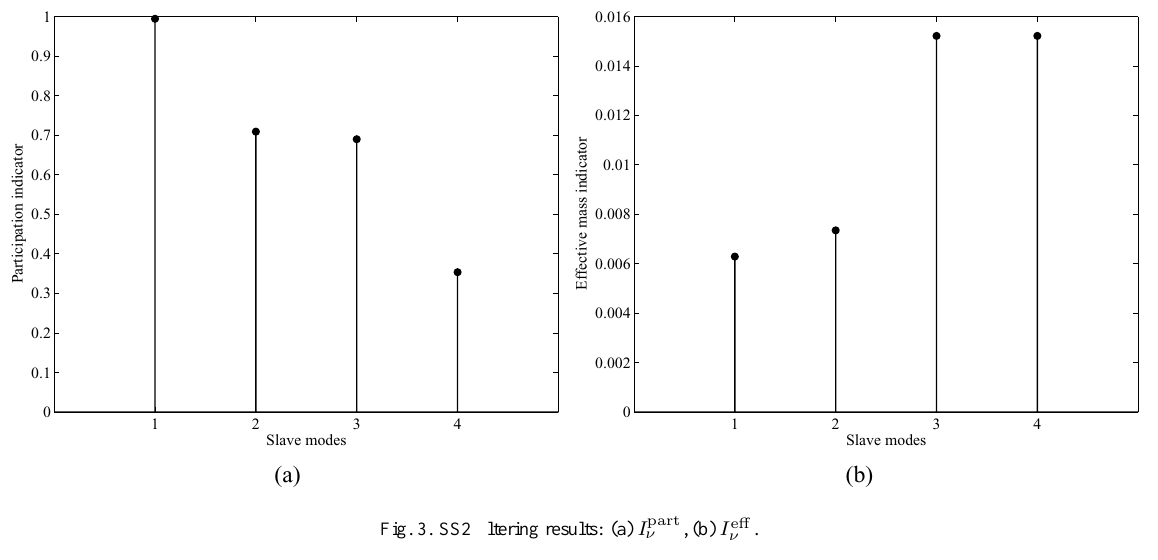
Fig. 3. SS2 filtering results: (a) I part ν , (b) I eff ν